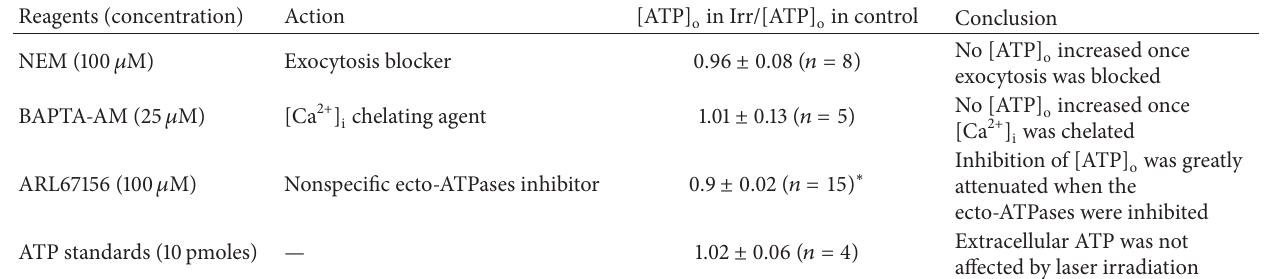
Table 2: The response of extracellular ATP contents to laser irradiation in presence of selected reagents.